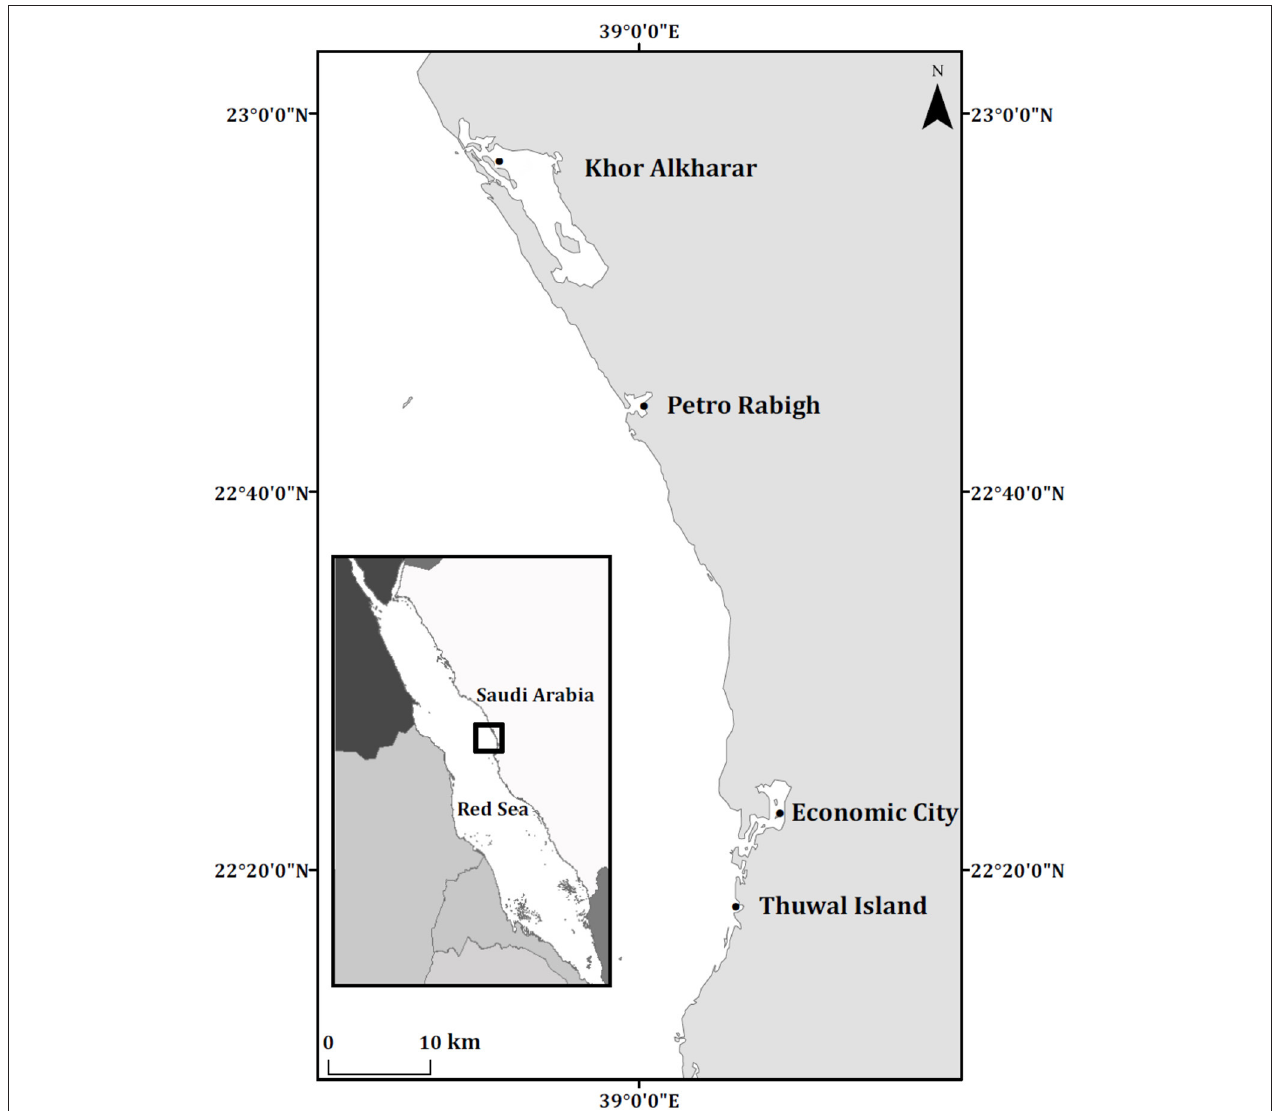
FIGURE 1 | Location of the Central Red Sea mangrove stands